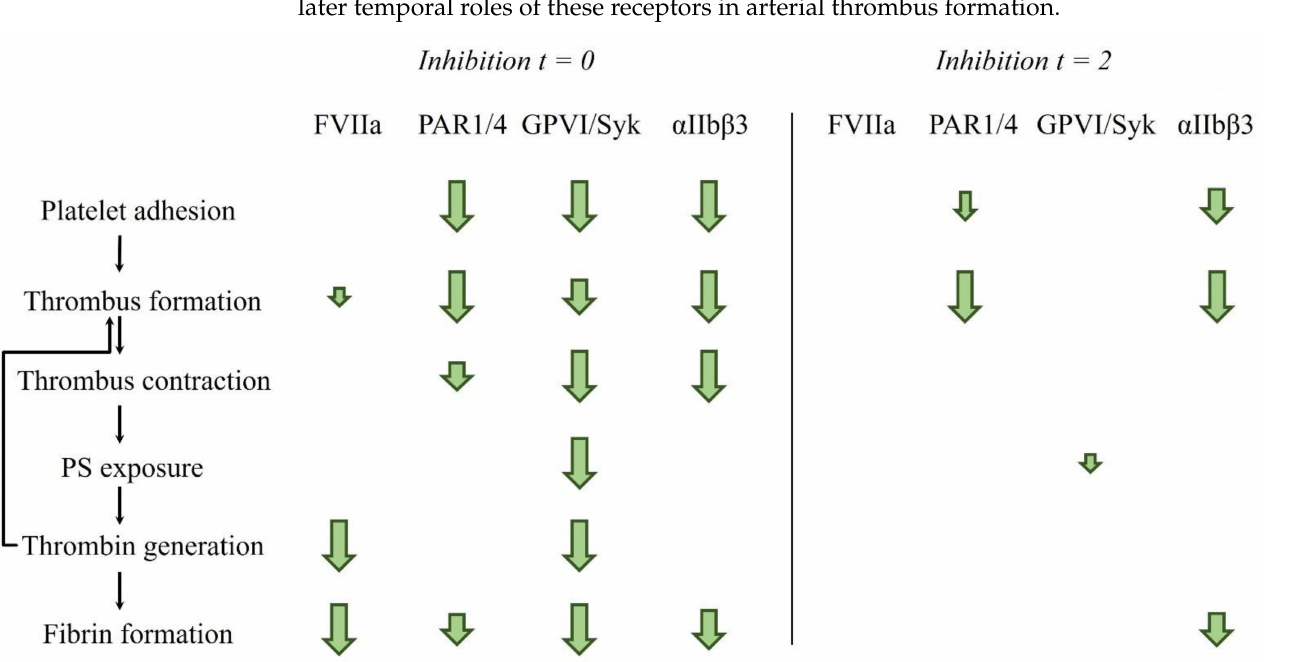
Figure 6. Schematic overview of early and late contribution of platelet and coagulation pathways in thrombus formation on collagen/TF surfaces under flow. Arrow sizes show to which extent inhibition of FVIIa, PAR1/4 receptors, GPVI signaling through Syk kinase, or integrin α IIb β 3 affect the early (0–2 min) and late (2–10 min) stages of the thrombotic